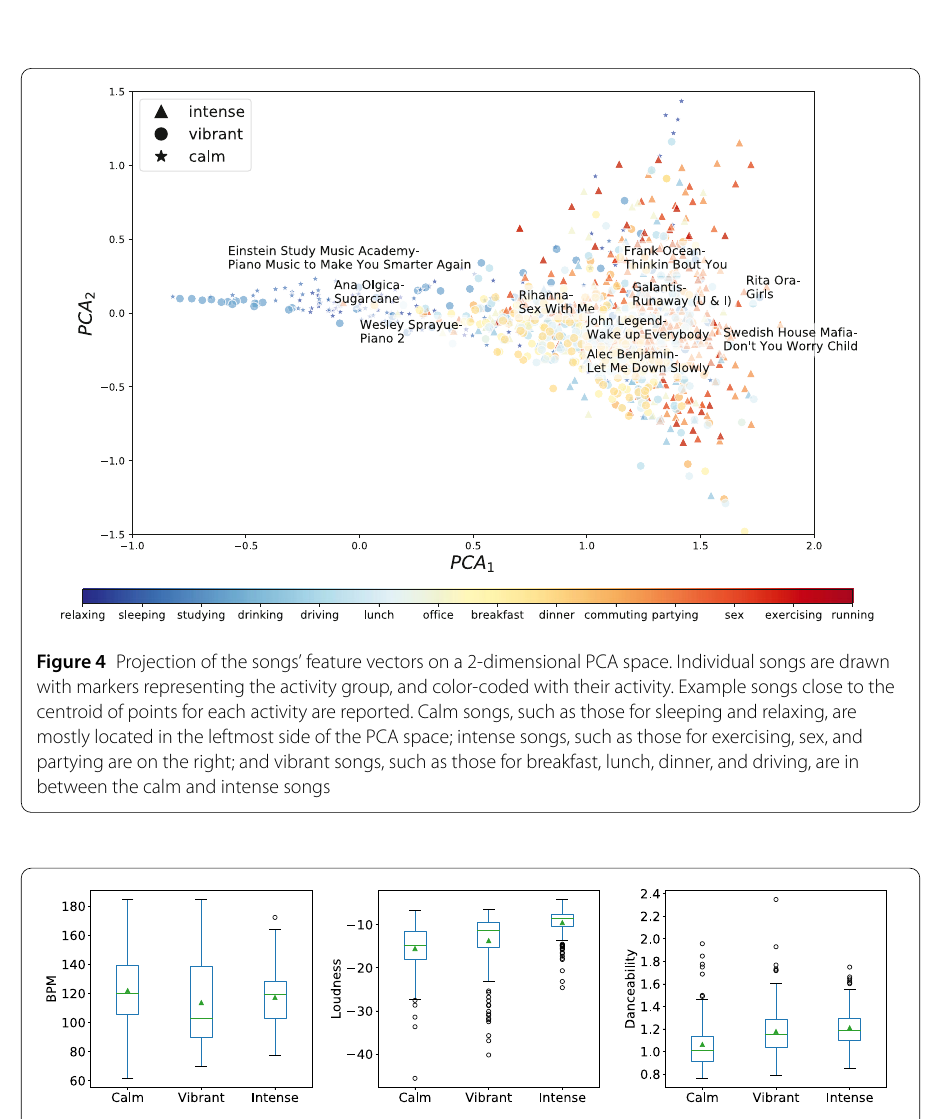
Figure 5 Tempo (left), Loudness (middle), and danceability (right) of the songs across the three music archetypes, namely, calm , vibrant , and intense . Both loudness and danceability are the highest for intense group and are the lowest for calm group, and the vibrant is in-between the two. For tempo, measured as beats per minutes, was the highest for the calm group, followed by the intense and vibrant groups. That is because the songs in the calm group are instrumental, such as classical music and music for mediation, and their beats are harder to automatically detect. Means are shown as triangles and medians as solid lines. The box whiskers indicate range including